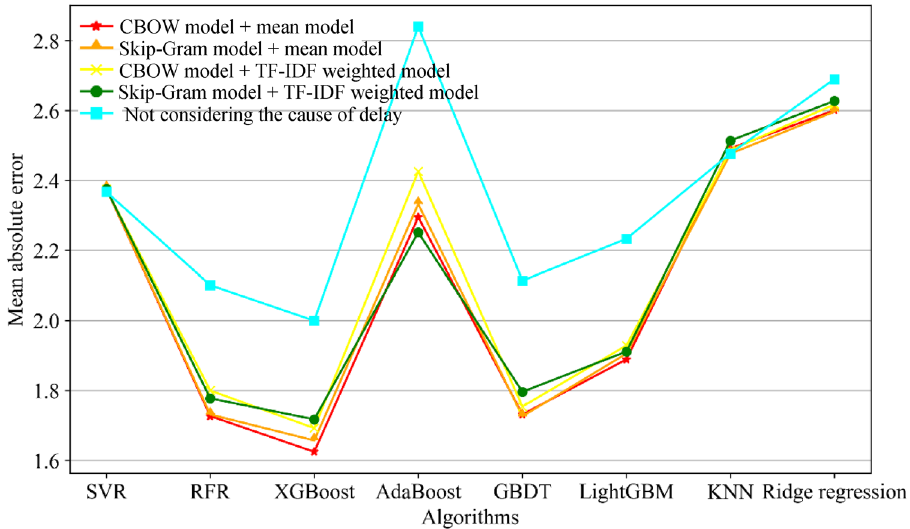
Fig. 17 Comparison between the prediction model which considers causal information and the prediction model without considering causal